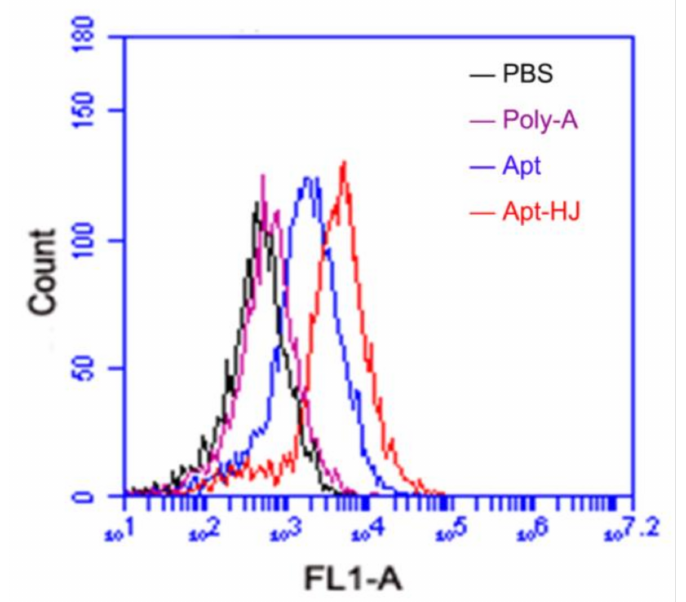
Figure 5. Flow cytometry analysis of CT26 cells after incubation with PBS (black), Carboxyfluorescein (FAM)-labeled poly-A (purple), PD-L1 Apt (blue), or Apt-HJ (red). CT26 cells (2 × 10 5 ) were treated with FAM-labeled poly-A, Apt, or Apt-HJ (60 pmol/250 µ L), washed thrice with PBS, and analyzed by flow